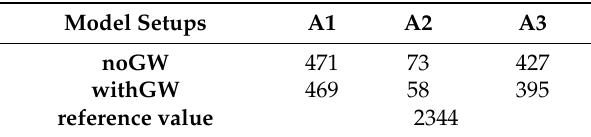
Table 2. Intersection sizes: The number of global behavioural runs calculated for the plots A1, A2 and A3 and the model setups with and without groundwater influence (withGW and noGW). The reference value represents the expected value derived from a hypothetical model which simulates 4 uncoupled target values.